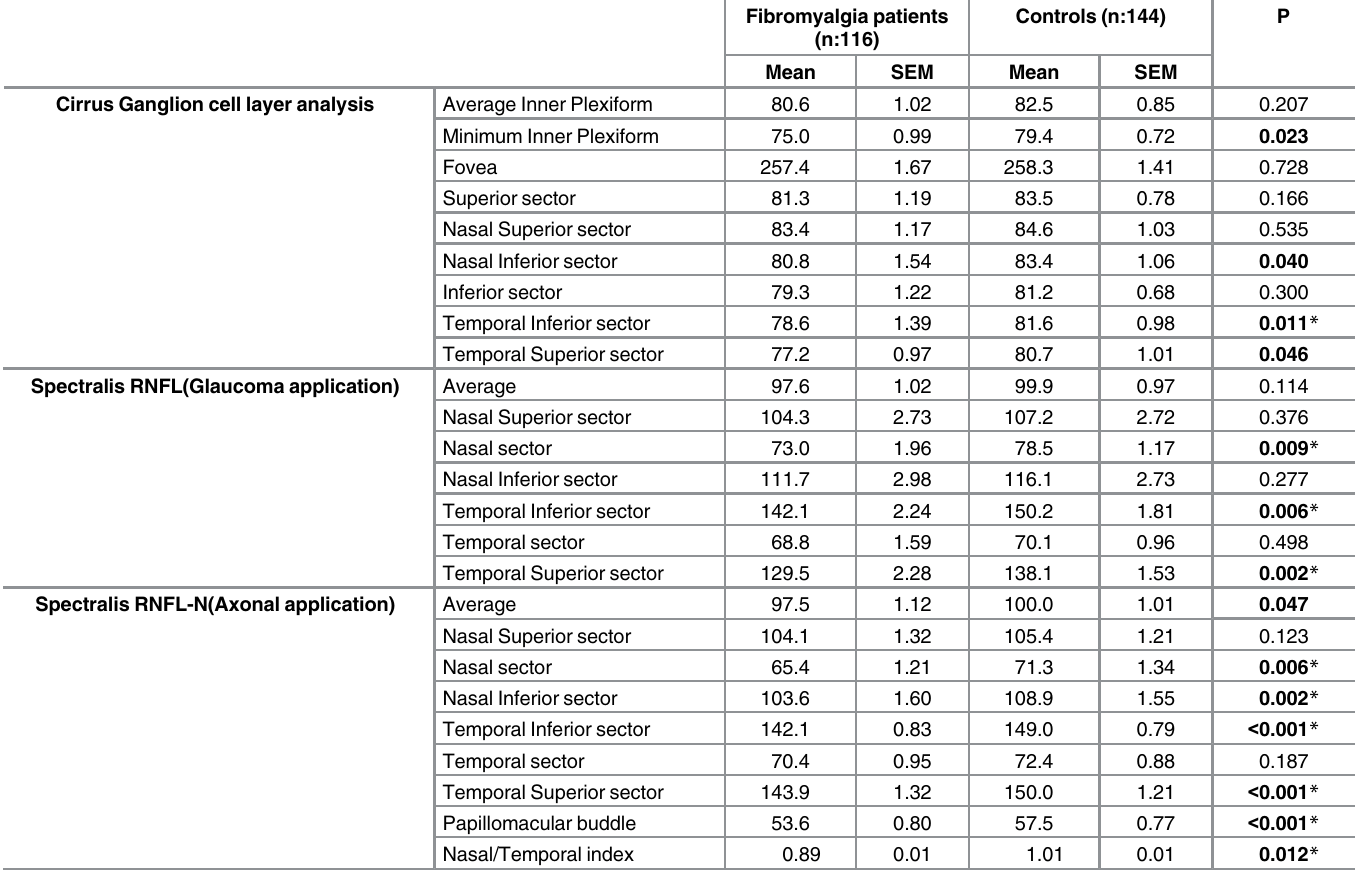
Table 2. Mean and standard error of the mean of retinal nerve fiber layer thicknesses obtained with the Cirrus and Spectralis optical coherence tomography devices in patients with Fibromyalgia syndrome and controls, and statistical